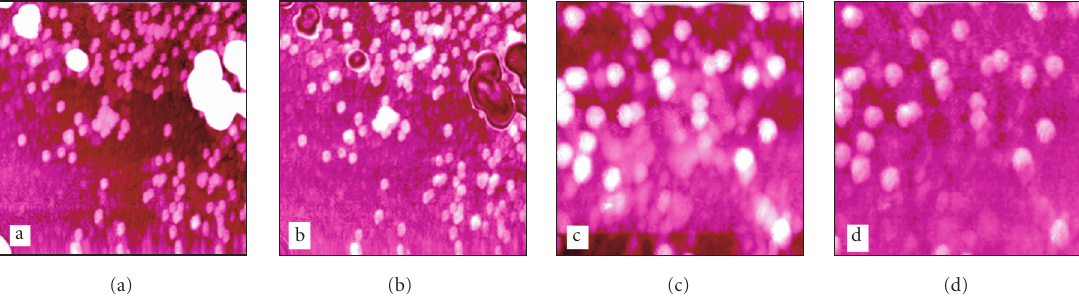
Figure 39: Shear-force AFM (a) (10 μ m, Z range 300nm), (c) (5 μ m, Z range 200nm), and apertureless SNOM (b), (d) of a dried SERS- inactive au sol on a microscope slide.